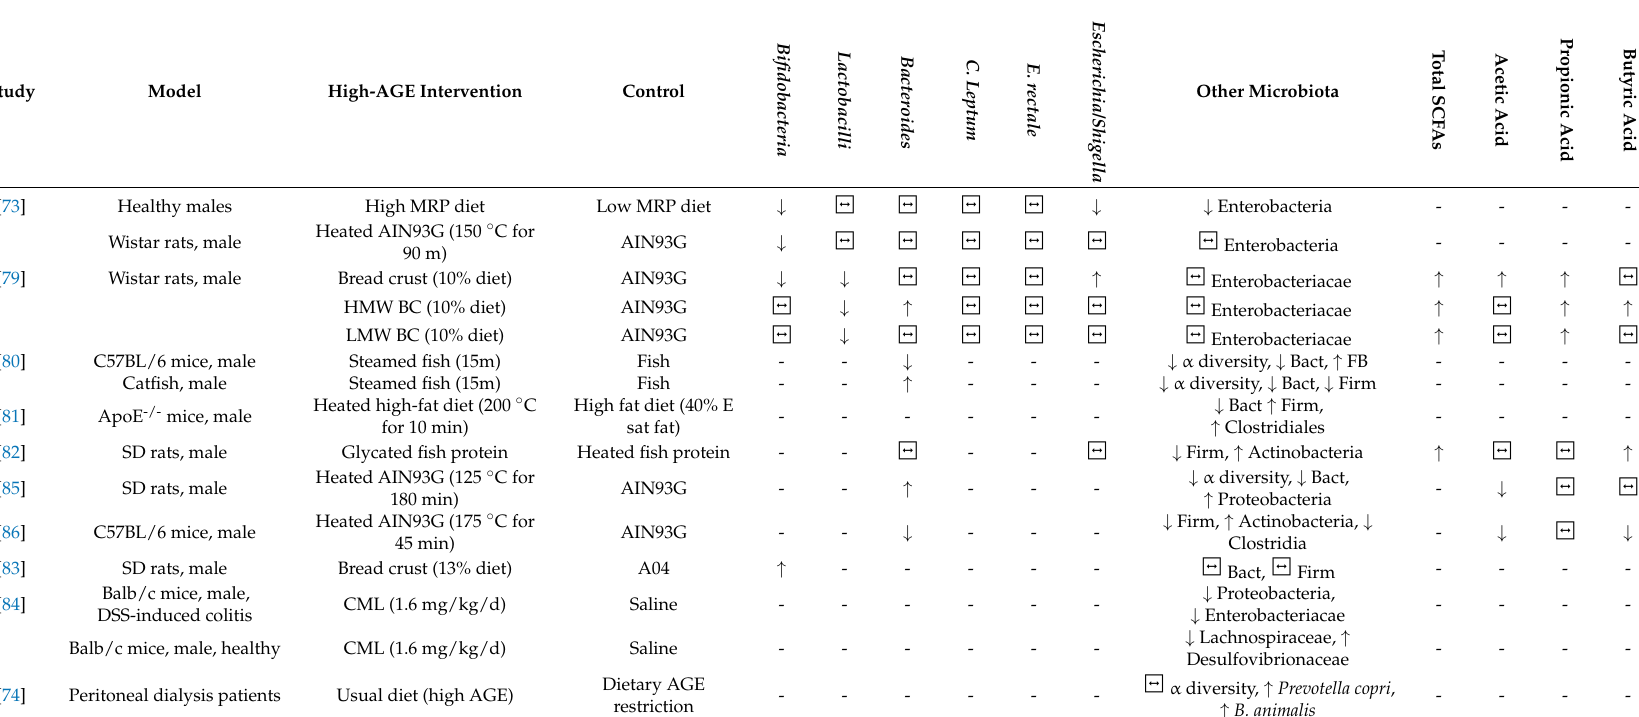
Bact, Bacteroidetes; BSA, bovine serum albumin; Firm, Firmicutes; SCFA, short-chain fatty acid, SRB, sulphate-reducing bacteria; UC, ulcerative colitis. ↑ = increased, ↓ = decreased, ↔ = no change, - = not reported. 1 Reported SCFAs as ratios rather than absolute values and was not included.